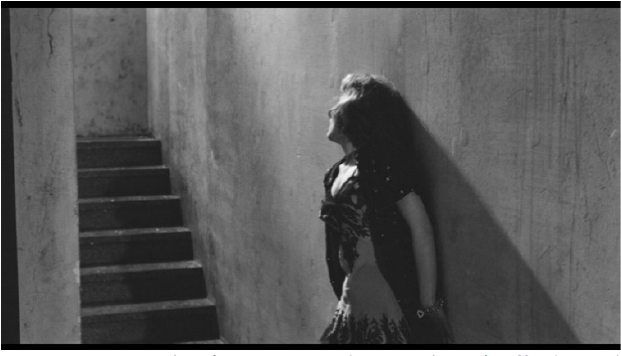
Figure 13 Screenshot from Rocco and His Brothers. (Goffredo Lombardo.)